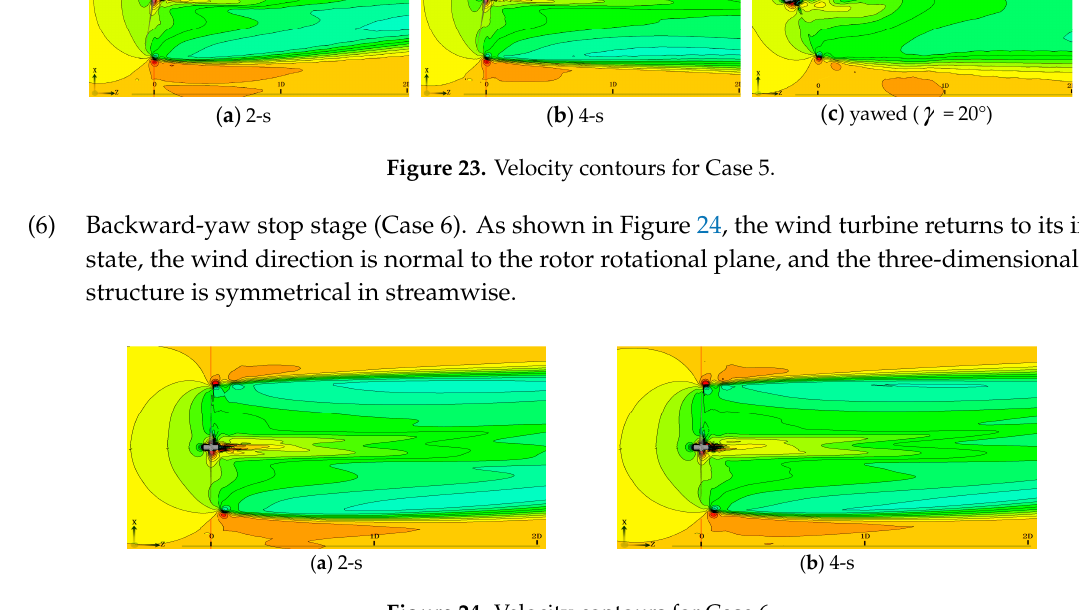
Figure 24. Velocity contours for Case 6.